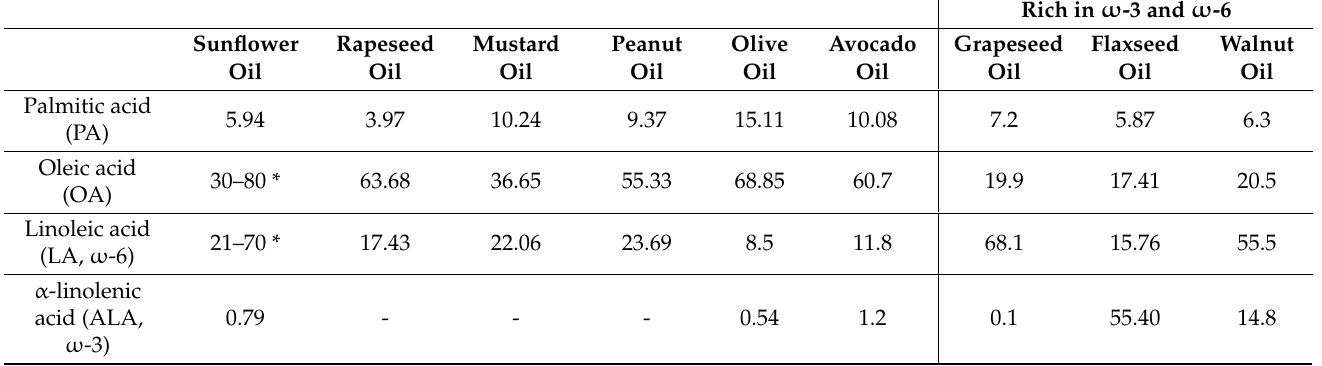
Table 1. Content of important fatty acids in plant oils commonly used as food sources (% from all FA) [149–152].